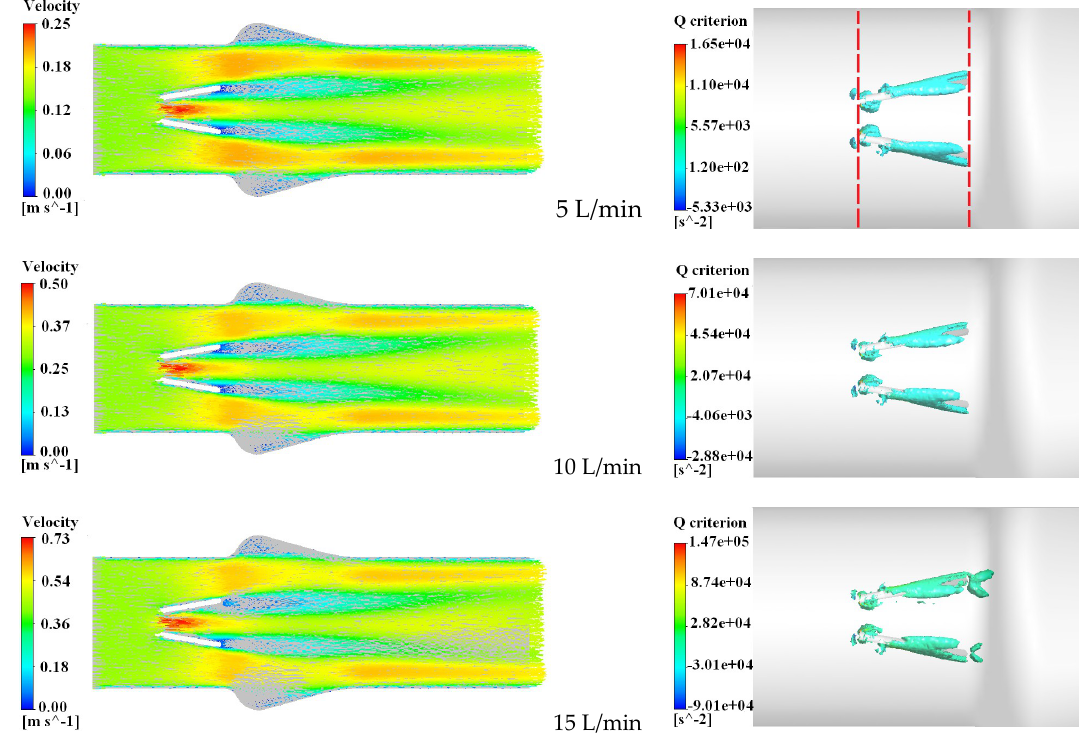
Figure 3. Comparisons of the velocity profiles between the simulation results by different turbulent models and the experiment results [15,22]. ( a ) Monitoring line at 2.54 mm cross-section after the leaflets. ( b ) Current simulation results and previous experimental data for velocity